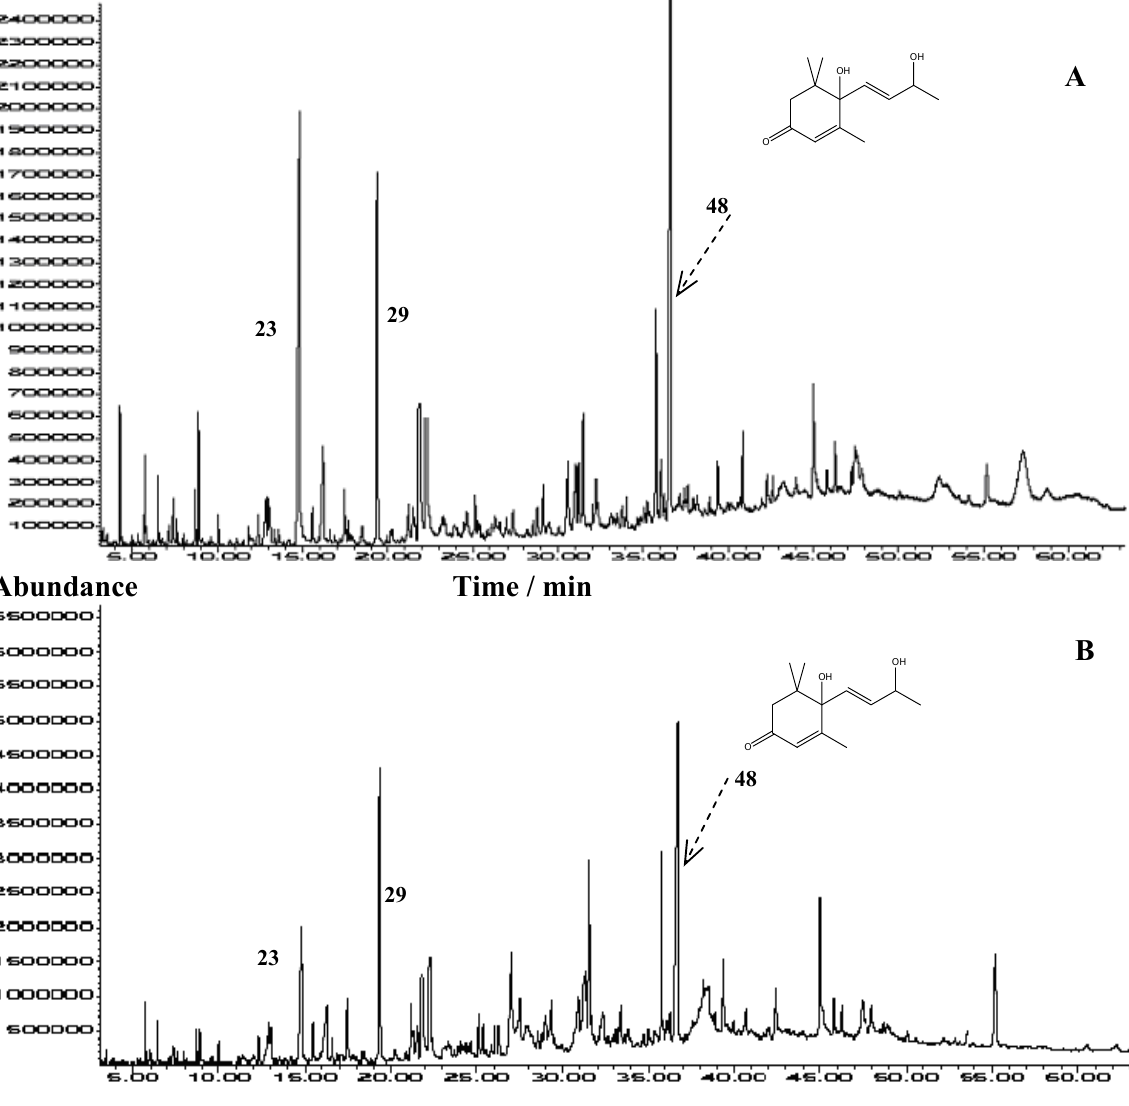
Figure 1. Representative TIC chromatograms of sulla honey extracts obtained by USE: A - dichloromethane extract; B - pentane and diethyl ether (1:2 v/v) extract. Numbers refer to Table